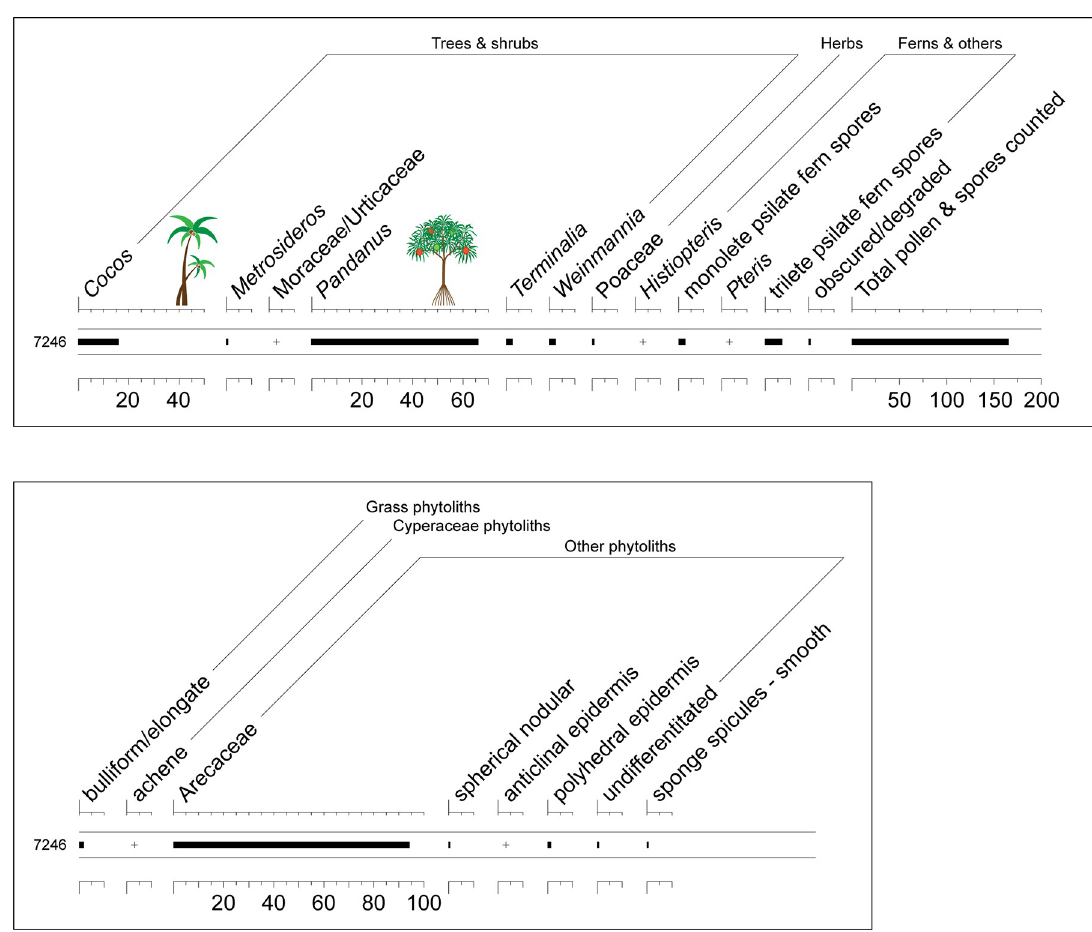
Fig 6. Microfossils assemblages from Layer IV, Ho‘oumi Beach. Top: Pollen record. Bottom: Phytolith and sponge spicule assemblage.